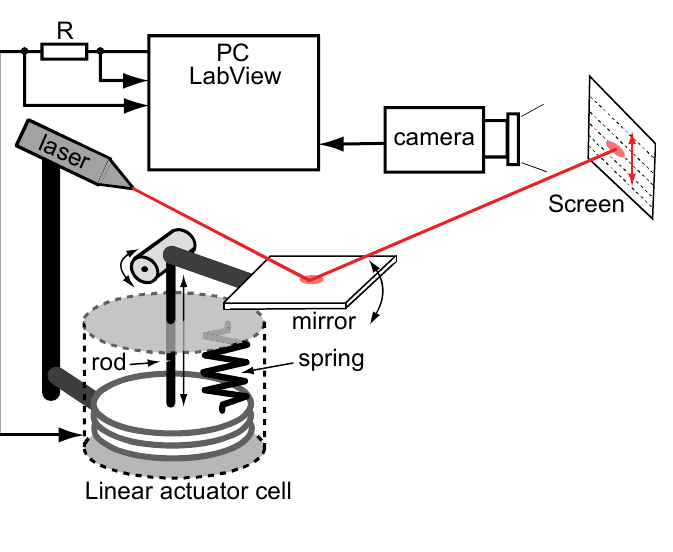
Figure 5. Experimental